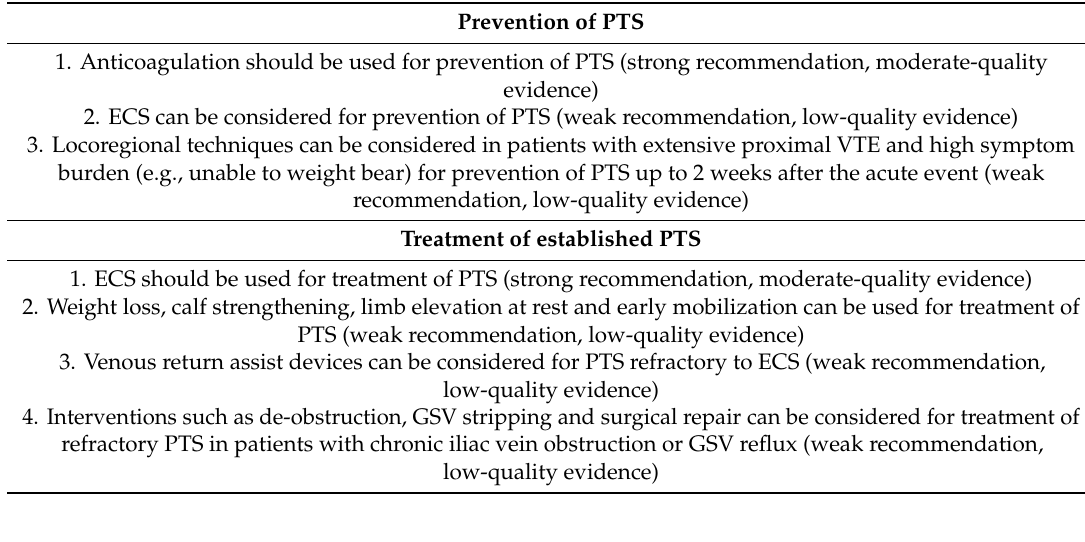
Table 2. Summary of